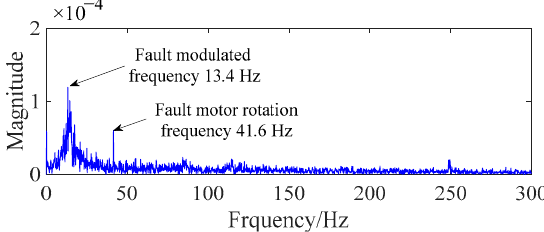
Figure 10. The spectrum of overload-current signal.